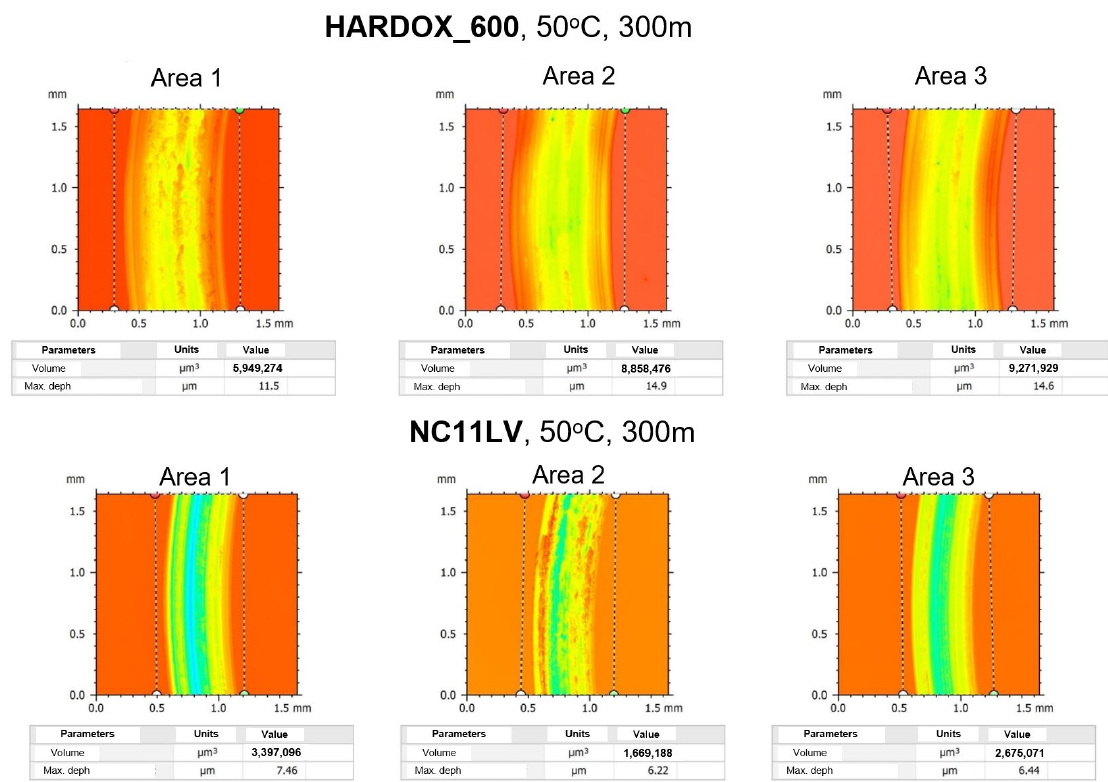
Figure 8. Detailed characteristics of material loss for the analyzed materials.